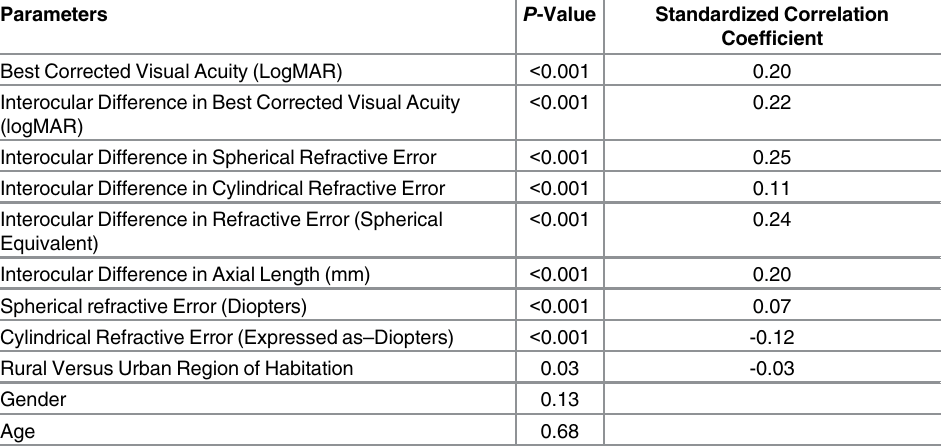
Table 3. Associations (Univariate Analysis) between Stereoacuity (Expressed as Logarithm of the Measured Angle of Binocular Disparity) and Systemic and Ocular Parameters in the Shandong Chil-